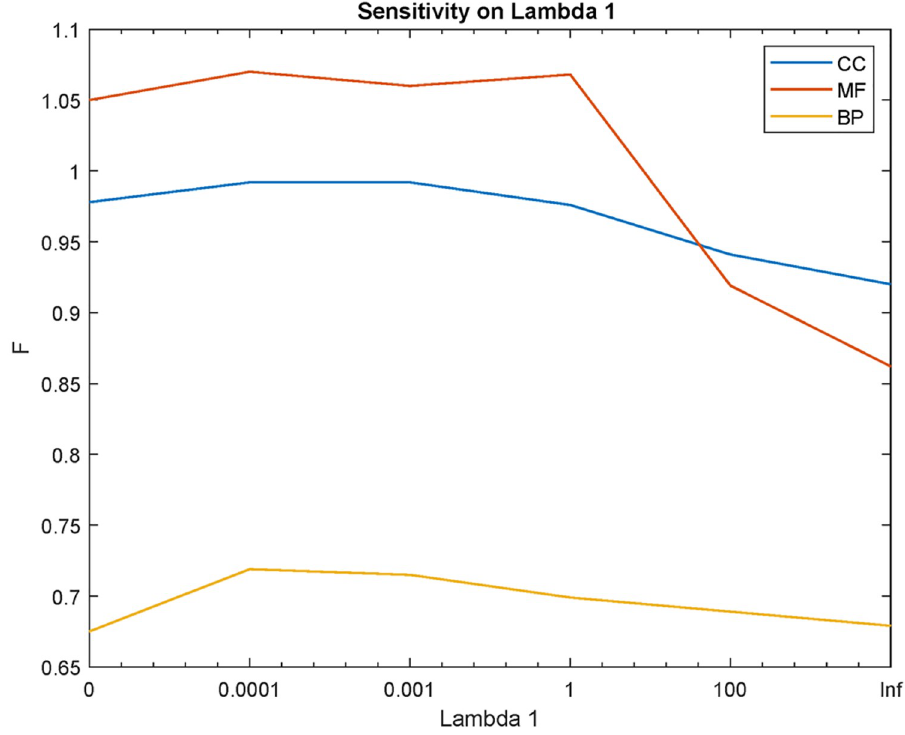
Fig 6. Sensitivity of the PFP-WGAN on parameter λ 1